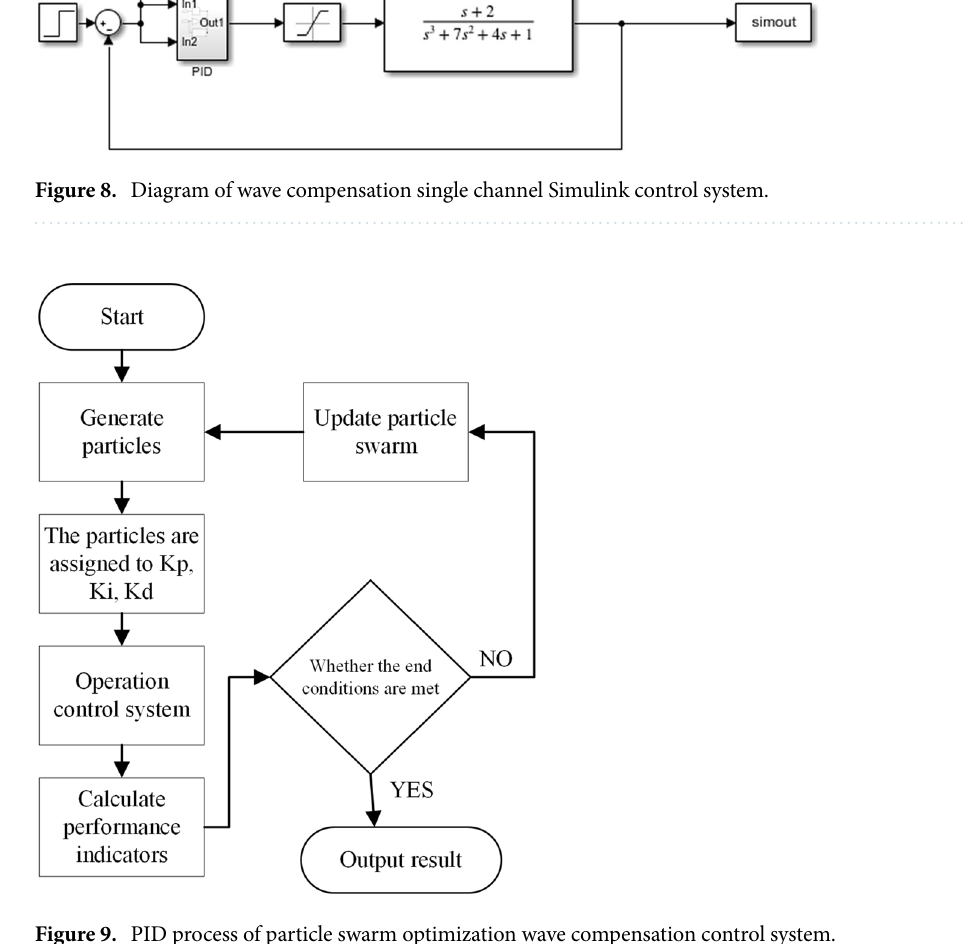
Figure 9. PID process of particle swarm optimization wave compensation control